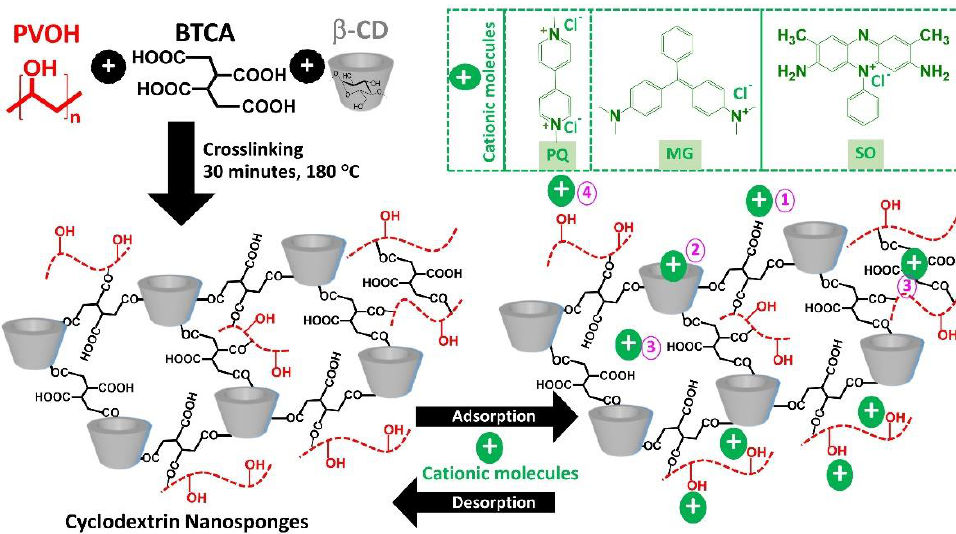
Figure 1. Schematic reaction of cyclodextrin nanosponges and the possible adsorption mechanism with cationic contaminants.